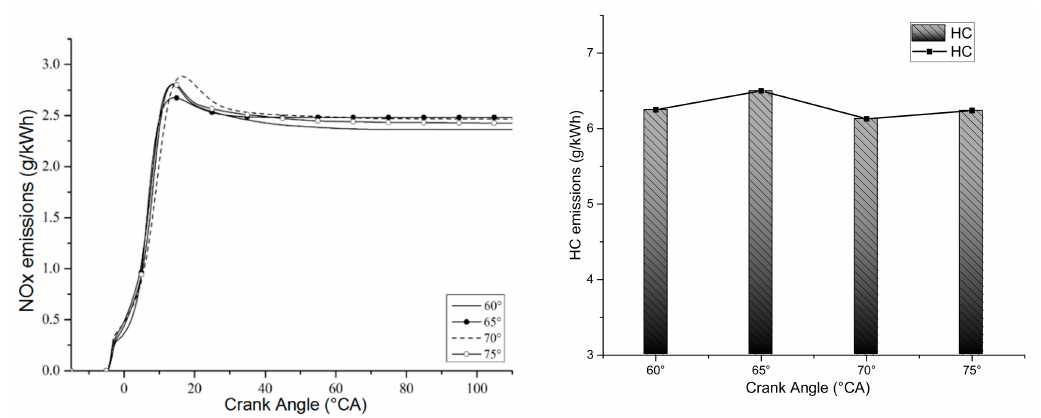
Figure 19. NOx and HC emissions at di ff erent PCC nozzle